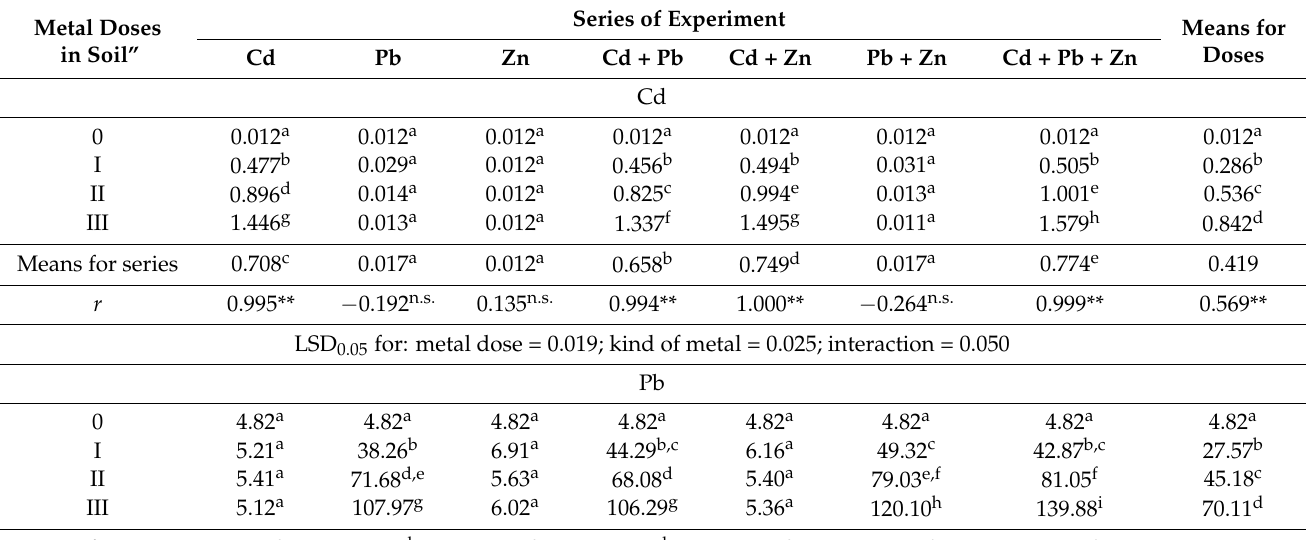
Table 1. Content of available forms of Cd, Pb and Zn, in mg kg − 1 of